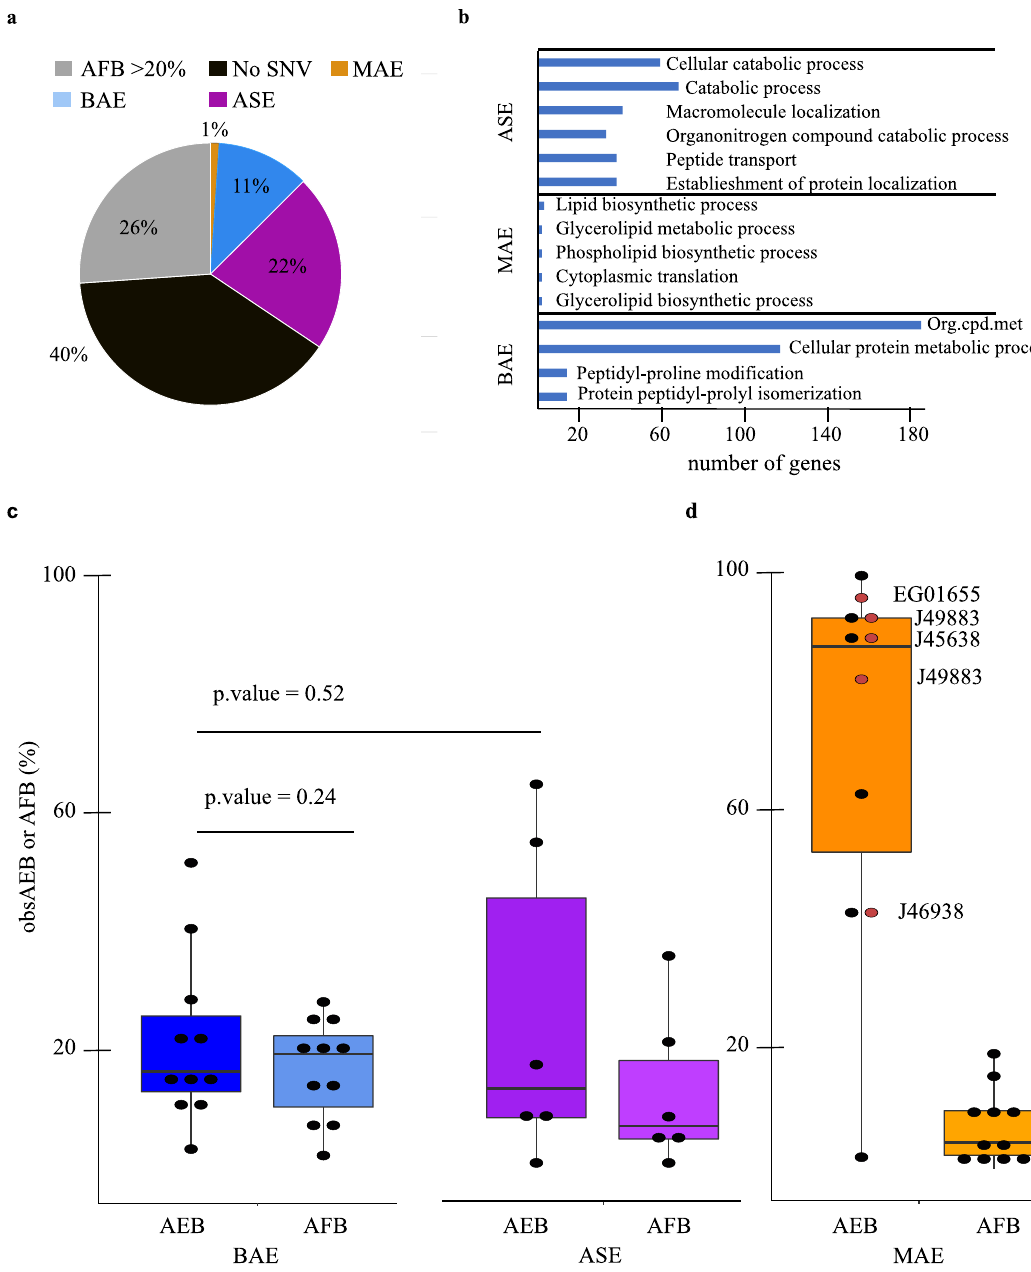
Figure 1. Characterization of allele-specific expression in the model diatom P. tricornutum . ( a ) Number of genes in allele-specific expression categories as a percentage of total genes in P. tricornutum. ( b ) Examples of the most specific and abundant gene ontologies (biological processes) in ASE, BAE and MAE genes based on TopGO analysis (see also Supplementary Dataset 2). Org.cpd.met = Organic nitrogen compound metabolism. ( c ) Box plot representation of obsAEB (cDNA) and obsAFB (gDNA) values as per pyrosequencing results for a subset of MAE, BAE and ASE SNV. For each SNV, AEB(AFB) was extrapolated from observed difference allelic frequencies. We also named and labelled by red dots the MAE genes tested in subclonal experiments (see Fig.